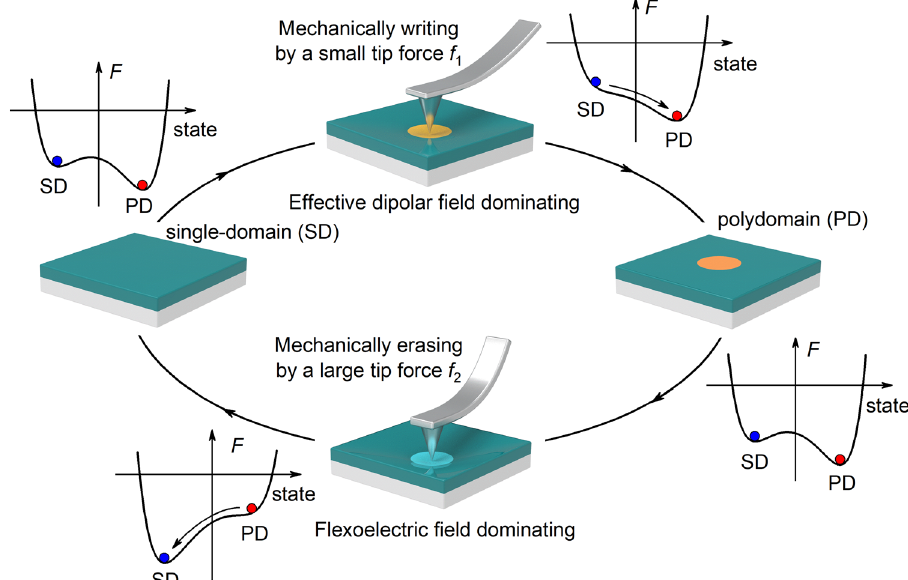
Fig. 1 Schematic of a bidirectional mechanical switching scheme. The effective dipolar fi eld is dominated at a relatively small tip force and can be employed to switch an initial downward SD state to an upward PD state, whereas the fl exoelectric fi eld is dominated at a relatively large tip force and can enable a back-switching. A reversible 180° mechanical switching scheme is achieved by applying tip force pulses with alternatively changing